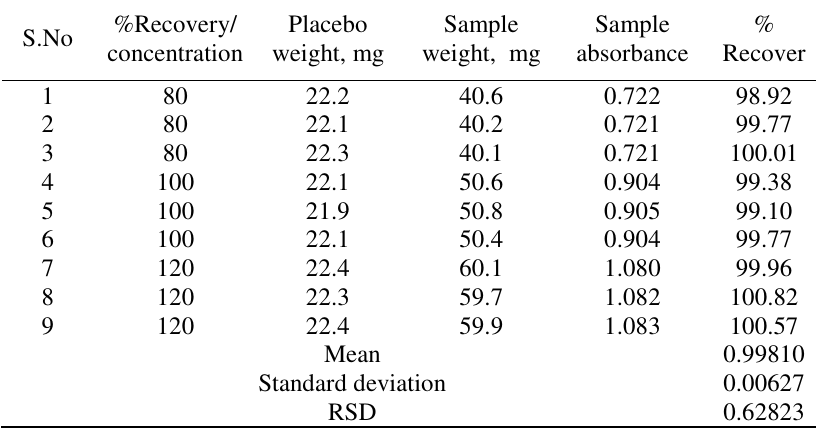
Table 3. Accuracy for metformin